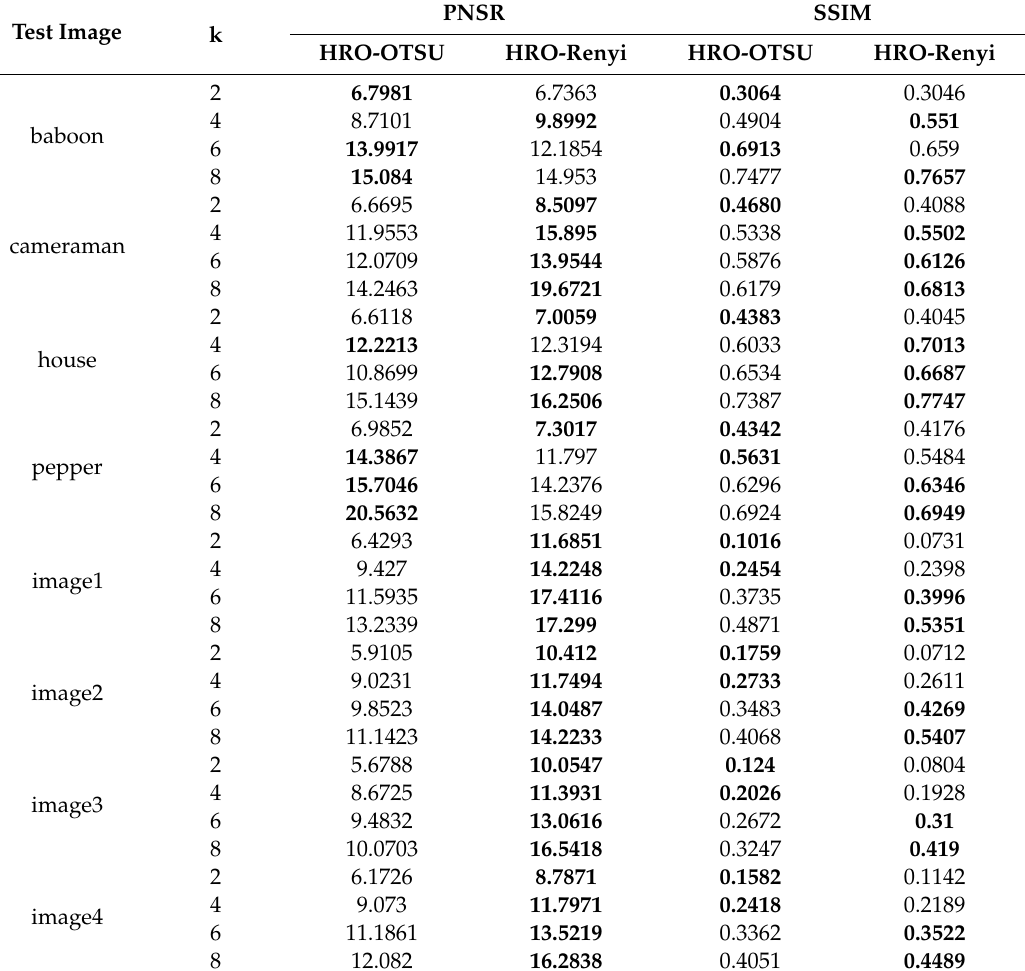
Table 4. PNSR, SSIM, regional consistency, and regional